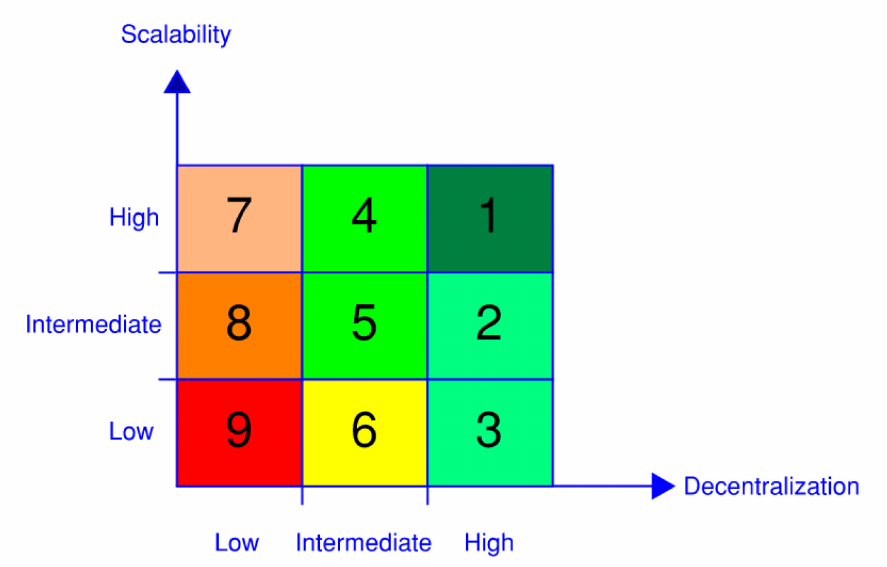
Figure 6. Categorization to evaluate blockchain networks’ suitability for